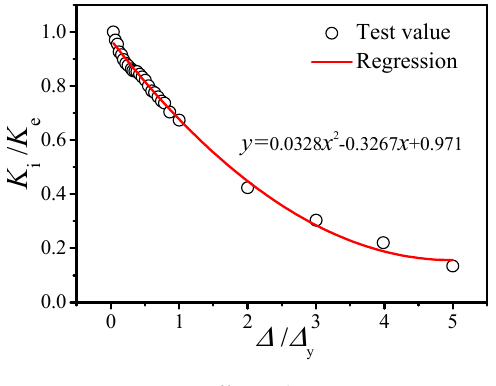
Figure 14. Sti ff ness Figure 14. Stiffness degeneration.